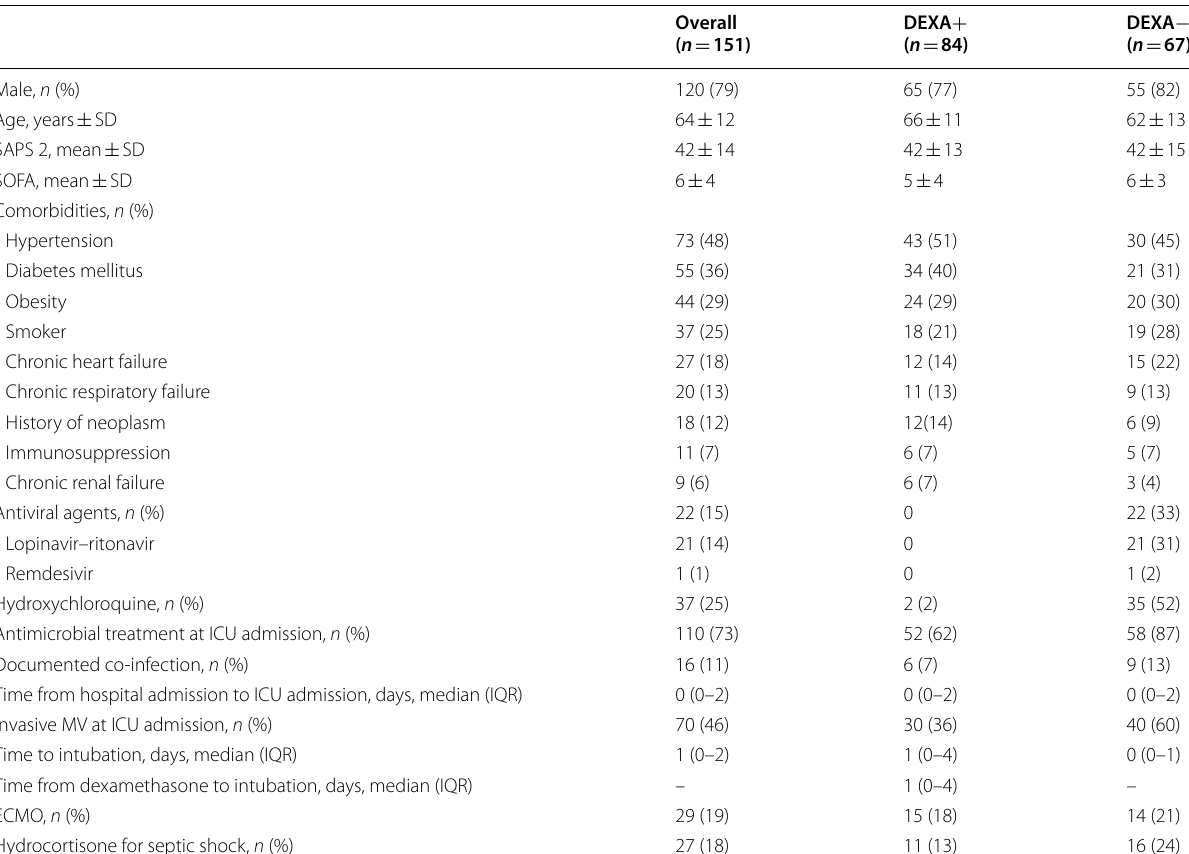
Table 1 Patients main characteristics at ICU